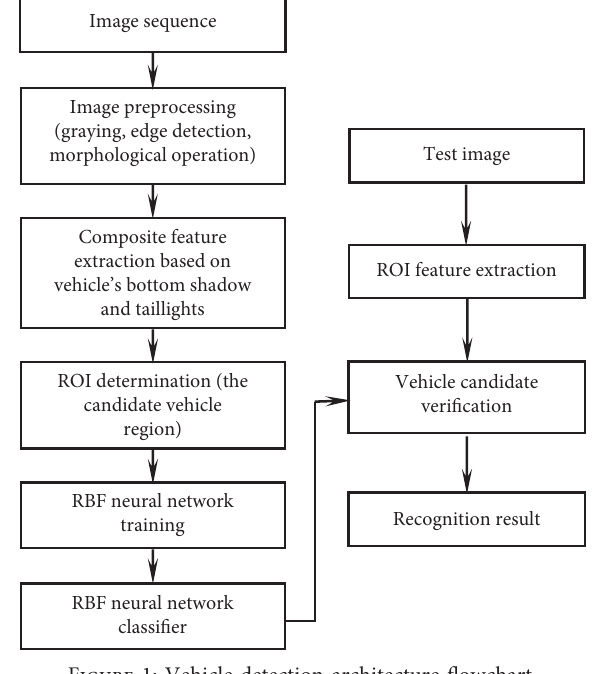
Figure 1: Vehicle detection architecture